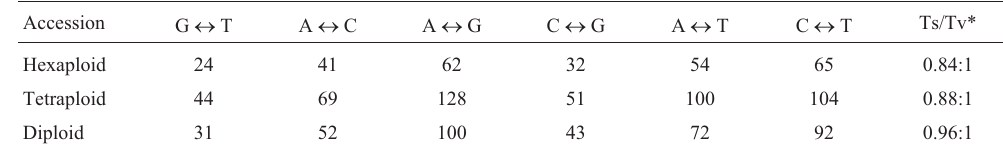
Table 4 - Base type substitutions in SNPs.